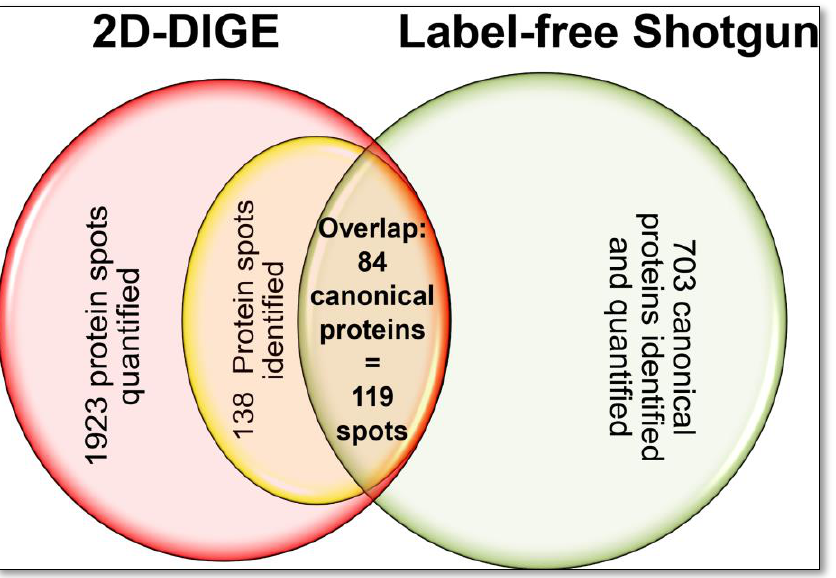
Figure 4. Overview of the number of investigated proteoforms and canonical proteins by 2D- DIGE and label-free shotgun. and label-free